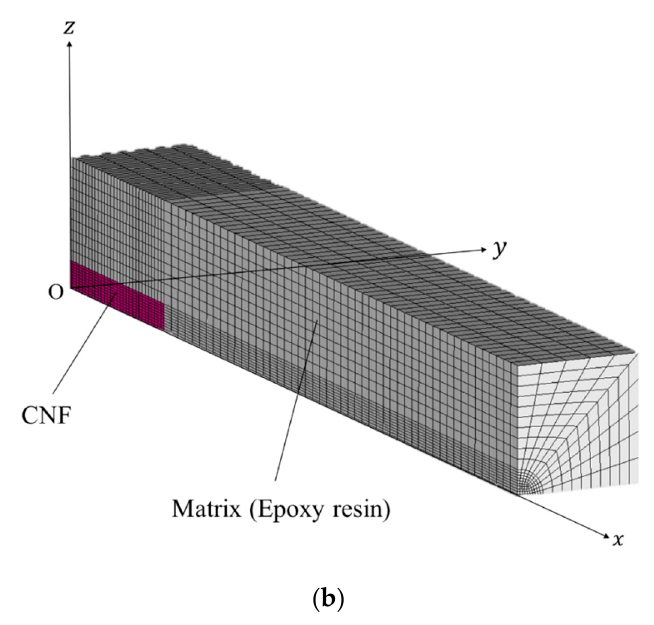
Figure 1. ( a ) Representative volume element (RVE) of cellulose nanofiber (CNF)-reinforced epoxy composite. ( b ) One-eighth finite element model of RVE for CNF-reinforced epoxy composite.